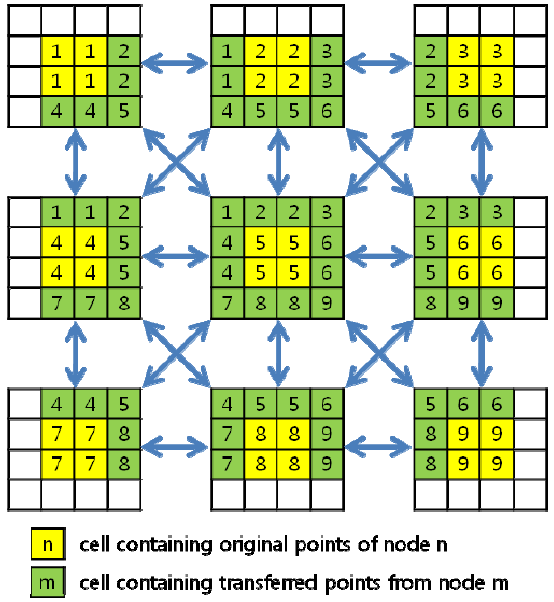
Figure 5. Transfer of marginal points among slave